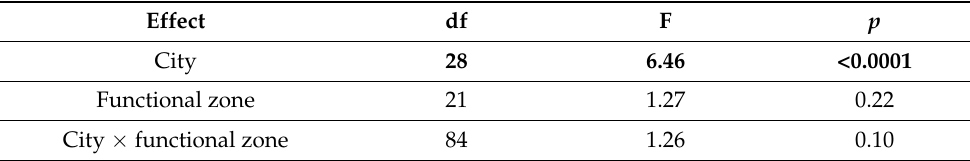
Table 4. MANOVA multivariate tests of